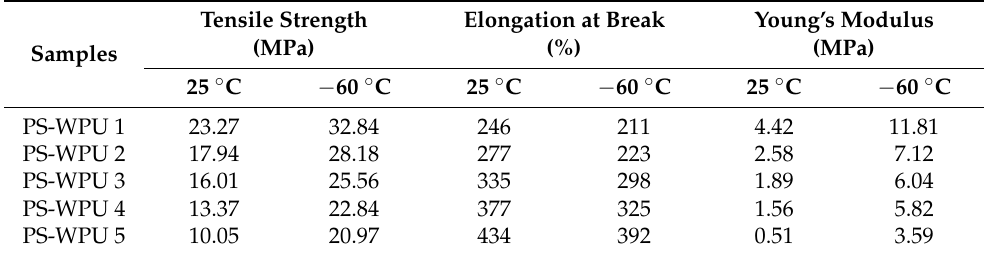
Table 5. Mechanical properties of PS-WPU